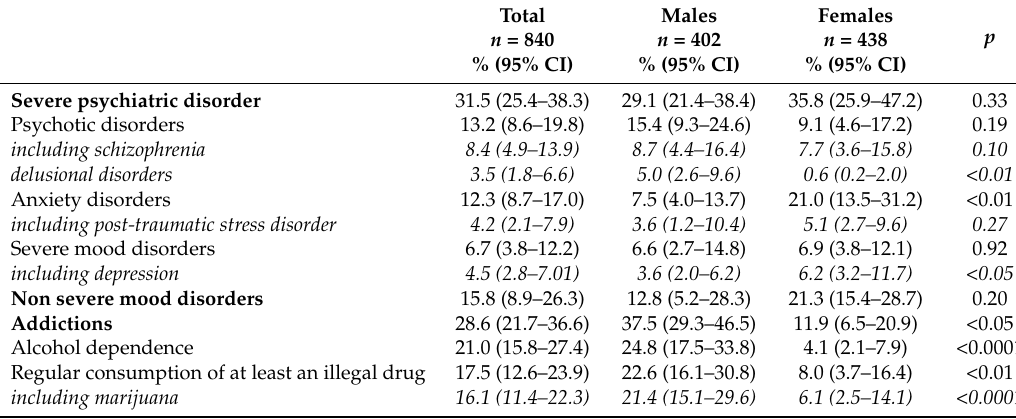
Table 1. Prevalence of psychiatric disorders and addictions in the entire homeless population and by gender, Greater Paris (France),